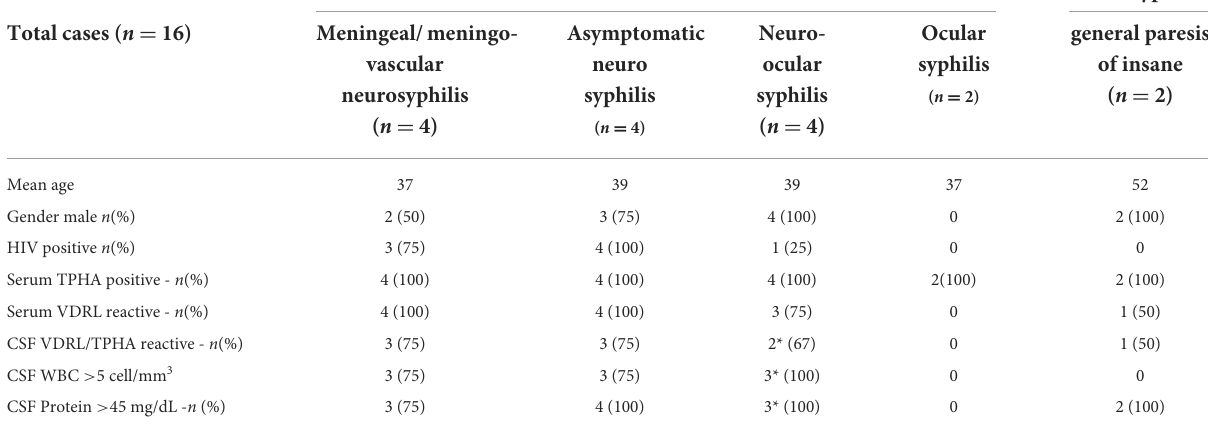
TABLE 2 Serum and CSF parameters of neurosyphilis